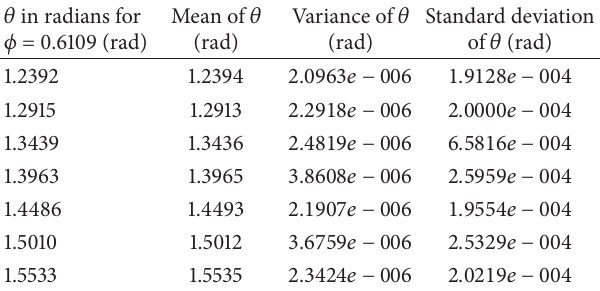
Table 11: Means, variances, and standard deviations at 10dB noise for different elevation angles and fixed azimuth angle by using GA- PS with 1-L-shape array [15].